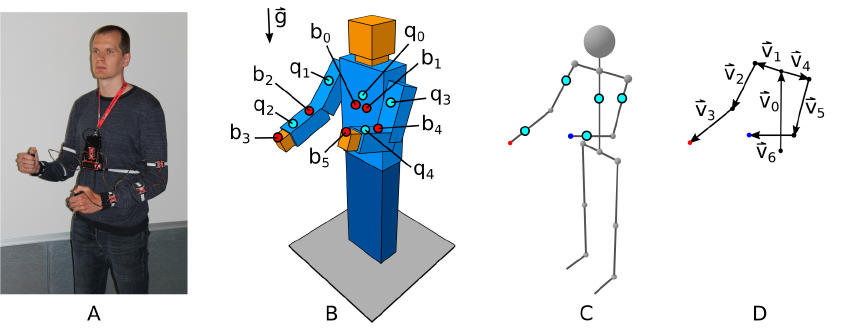
Figure 2. ( A ) The wearable IMU system, ( B ) the positions of IMUs and buttons, ( C ) the skeleton abstraction, and ( D ) the vector